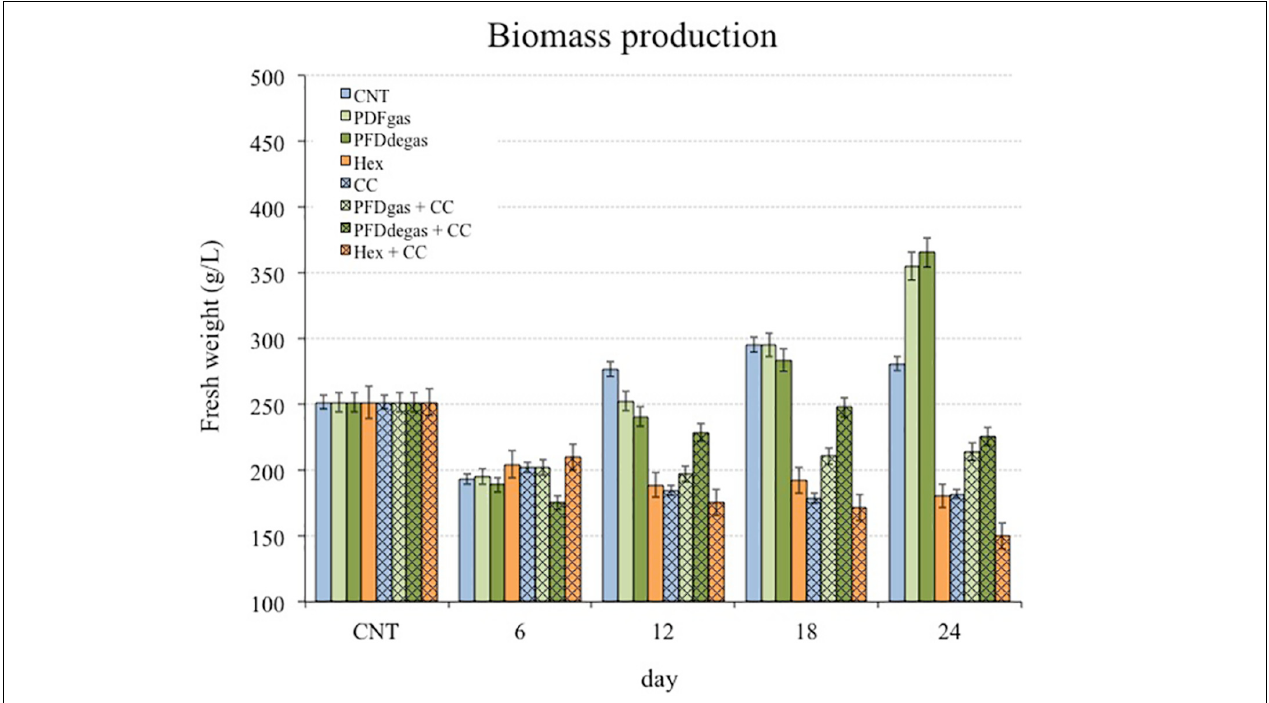
FIGURE 1 | Time course of cell growth in T. media cell cultures measured as g FW/L. CNT, control; PDFgas, gassed perfluorodecalins; PFDdegas, degassed perfluorodecalins; PDFgas + CC, gassed perfluorodecalins plus Coro and β -CDs; PDFdegas + CC, degassed perfluorodecalins and Coro + β -CDs; Hex, Hexenol; Hex + CC, Hexenol and Coro + β -CDs. Data are the mean of three independent replicates ±